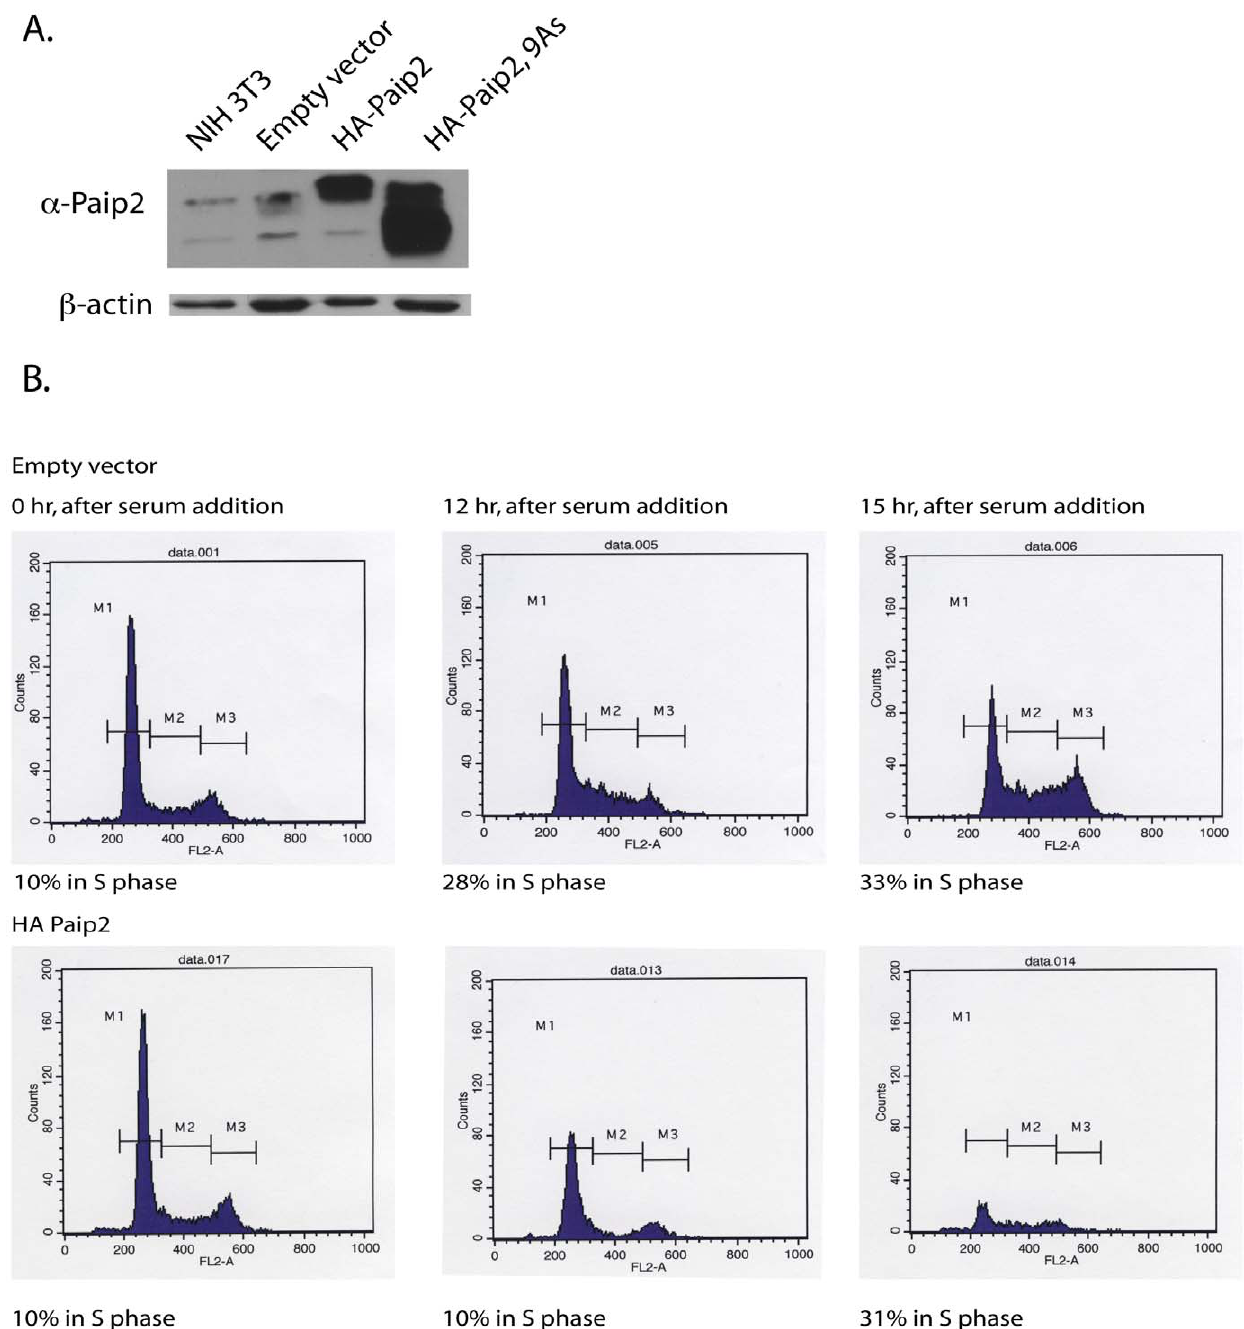
Figure 1. Cell cycle analysis of NIH 3T3 cells over producing Paip2. A. Western blot analysis of NIH3T3 cells alone, or infected with a retrovirus encoding for HA-Paip2 or HA-Paip2, 9As using anti-Paip2 antibody. B. Flow cytometry analysis demonstrating the 3-hour delay of entry into the cell cycle by BrUd staining of NIH3T3 producing wild type HA-Paip2 after the addition of serum following 72 hours of starvation.